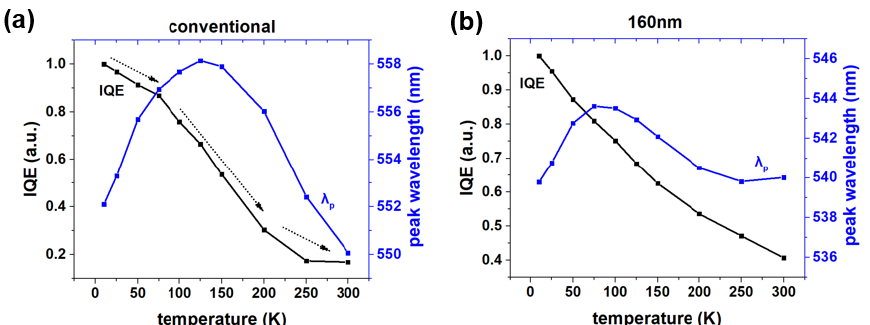
Figure 5. IQE and peak wavelength dependence on temperature drawn from TDPL spectra for ( a ) conventional and ( b ) nanorod LEDs. (Black line: IQE changes with the increase of temperature; blue line: peak wavelength changes with the increase of temperature.)